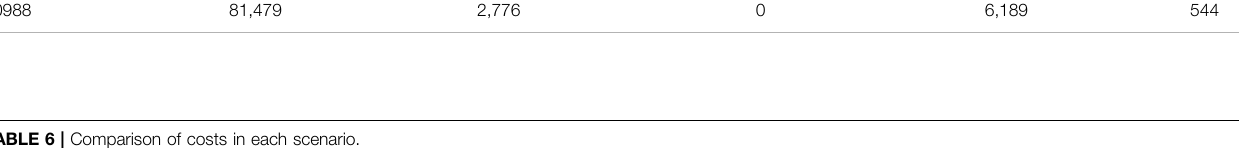
TABLE 6 | Comparison of costs in each scenario.